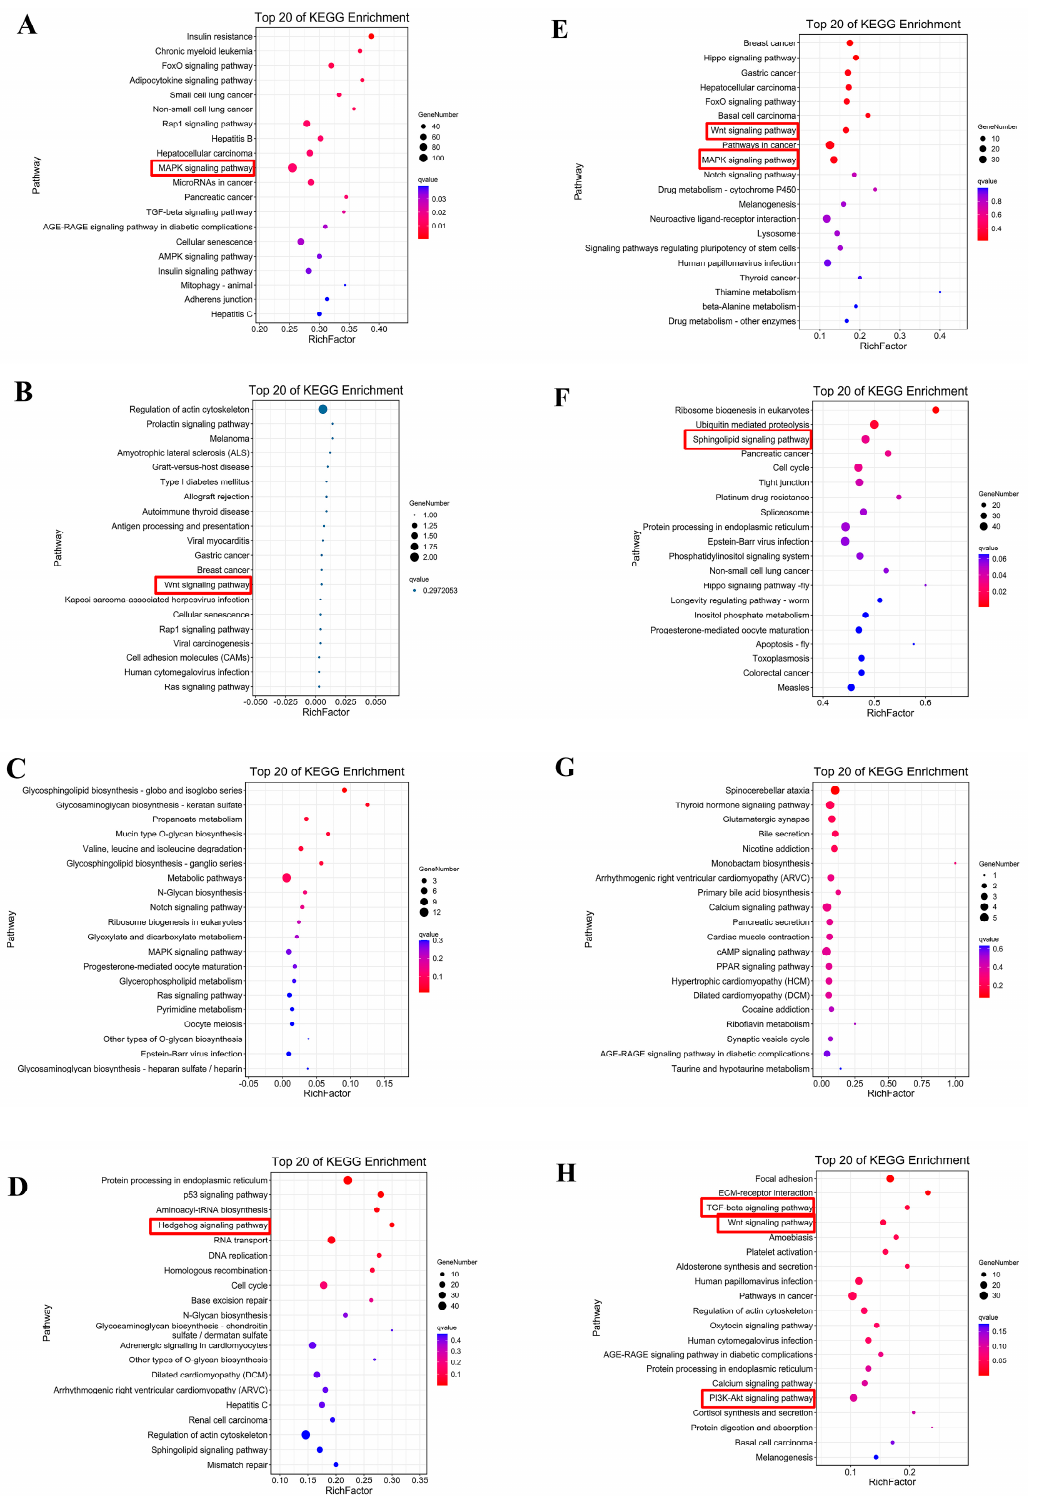
Figure 11. Kyoto Encyclopedia of Genes and Genomes (KEGG) functional enrichment analysis of the key gene modules of M. reevesii and P. sinensis . ( A ) Top 20 results of KEGG enrichment of cyan module. ( B ) Top 20 results of KEGG enrichment of brown 3 module. ( C ) Top 20 results of KEGG enrichment of coral 3 module. ( D ) Top 20 results of KEGG enrichment of navajo white 3 module. ( E ) Top 20 of KEGG enrichment of black module. ( F ) Top 20 results of KEGG enrichment of pink module. ( G ) Top 20 of KEGG enrichment of coral 1 module. ( H ) Top 20 results of KEGG enrichment of dark green